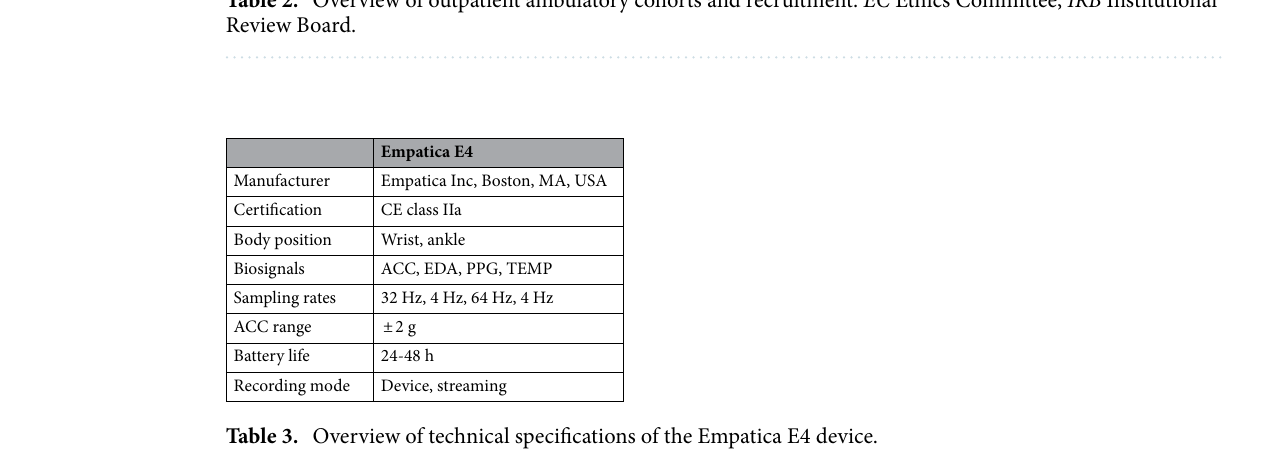
Table 3. Overview of technical specifications of the Empatica E4